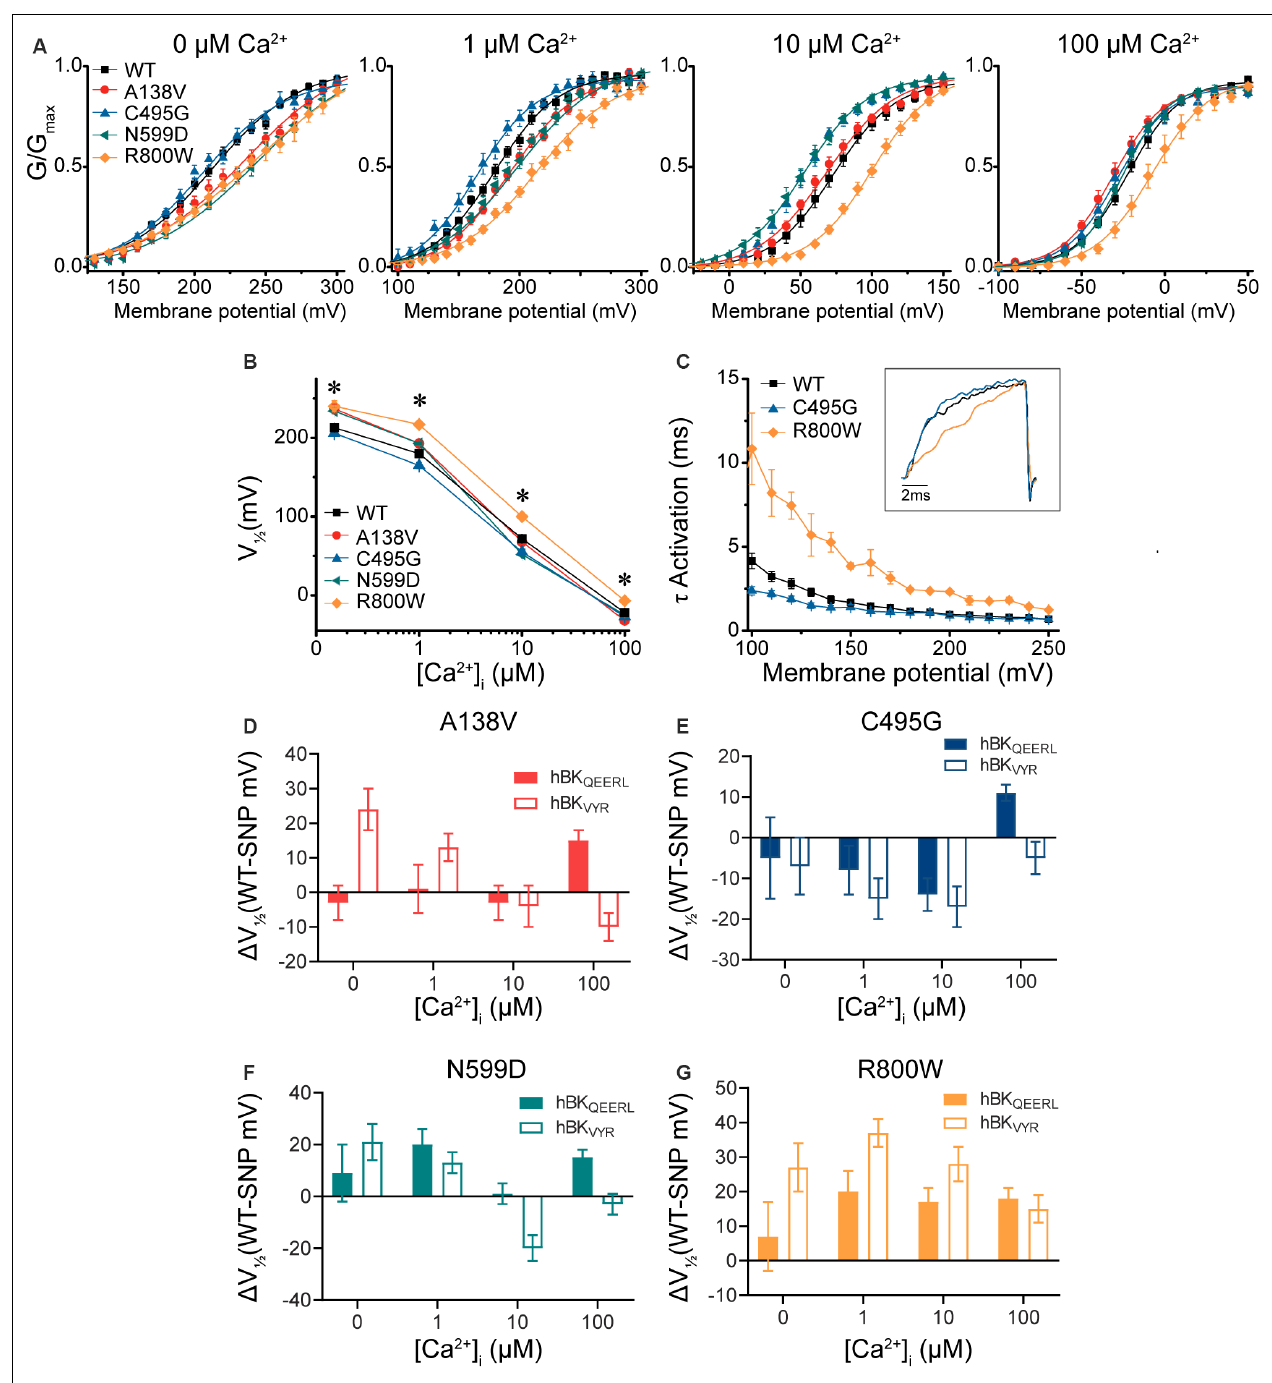
FIGURE 4 | BK current properties from SNP-containing hBK VYR channels. (A) G–V relationships from BK currents recorded in symmetrical K + solutions at 0-, 1-, 10-, and 100- µ M Ca 2 + from control WT hBK VYR channels and channels containing A138V, C495G, N599D, and R800W SNP substitutions. Voltage protocols identical to those in Figure 2 . (B) V 1 / 2 vs. Ca 2 + relationship. Significant differences in V 1 / 2 values between WT and SNP-containing channels were found at 0- (A138V, P = 0.006; N599D, P = 0.03; R800W, P = 0.001), 1- (A138V, P = 0.041; C495G, P = 0.03; N599D, P = 0.03; R800W, P < 0.0001), 10- (C495G, P = 0.02; N599D, P = 0.0008; R800W, P < 0.0001), and 100- µ M Ca 2 + (R800W, P = 0.003). ∗ P < 0.05, one-way ANOVA with Bonferroni post hoc tests comparing constructs at each Ca 2 + concentration. (C) τ Activation vs. voltage for WT, C495G, and R800W at 10- µ M Ca 2 + . Inset : normalized current traces from each construct evoked by a 20-ms voltage step to +100 mV. Compared with WT, C495G exhibited faster activation kinetics ( P = 0.002), while R800W exhibited slower activation kinetics ( P < 0.0001). ∗ P < 0.05, two-way repeated-measures ANOVA. (D–G) Summary of the difference in the average V 1 / 2 values ( ∆ V 1 / 2 in mV) between WT and SNP-containing channels for hBK QEERL and hBK VYR variant backgrounds. N = 8–21 recordings per construct at each Ca 2 + concentration.